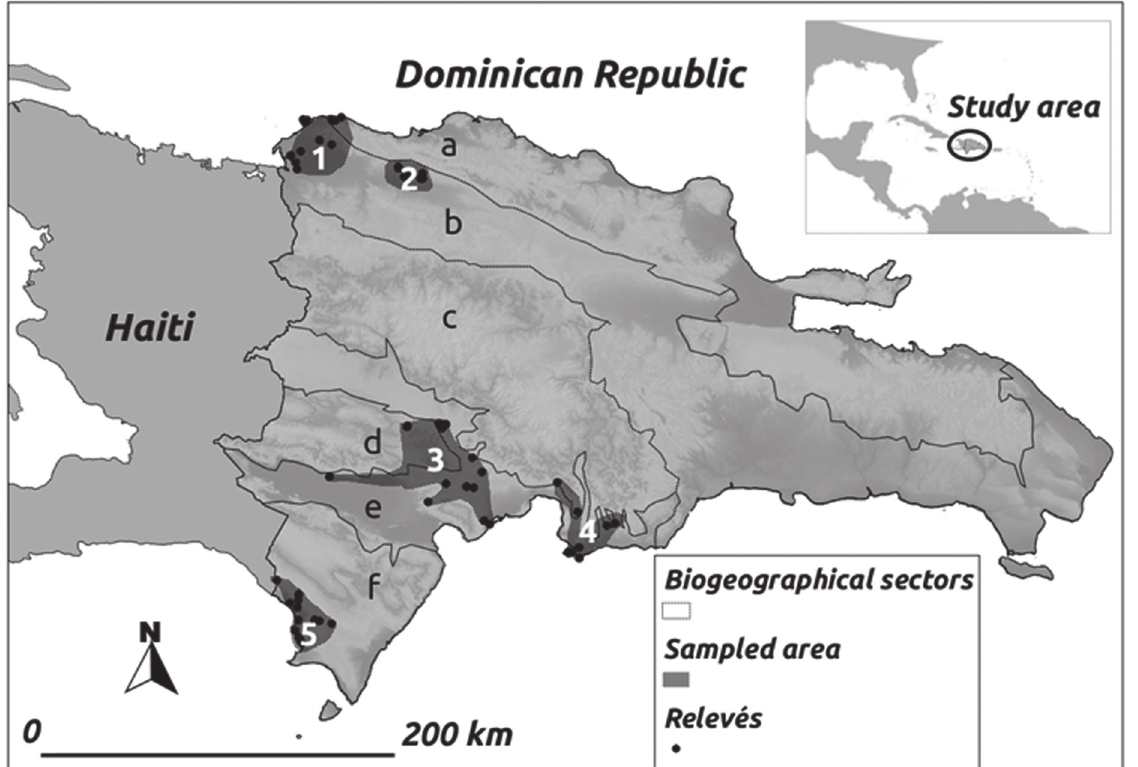
Figure 1 - Location of the phytosociological relevés conducted in the study area: (1) Relevés 41, 42, 43, 54, 55, 56, 57, 58, 59, 60, 61, 62, 63, 64, 65, 66, 67, 68, 69. (2) Relevés 40, 45, 46, 47, 48, 49, 50, 51, 52, 53. (3) Relevés 7, 8, 9, 10, 11, 12, 13, 14, 15, 27, 28, 31, 32, 36, 37, 44. (4) Relevés 1, 2, 3, 4, 5, 6, 29, 30, 38, 39. (5) Relevés 16, 17, 18, 19, 20, 21, 22, 23, 24, 25, 26, 33, 34, 35. Biogeographical sectors: (a) North. (b) Caribbean-Cibensean. (c) Central. (d) Neiba-Matheux-Northwest. (e) Azua-San Juan-Hoya Enriquillo-Port-au-Prince-Artiobonite-Gonaivës. (f) Bahoruco-Hottensean. (Taken and adapted from Cano et al.